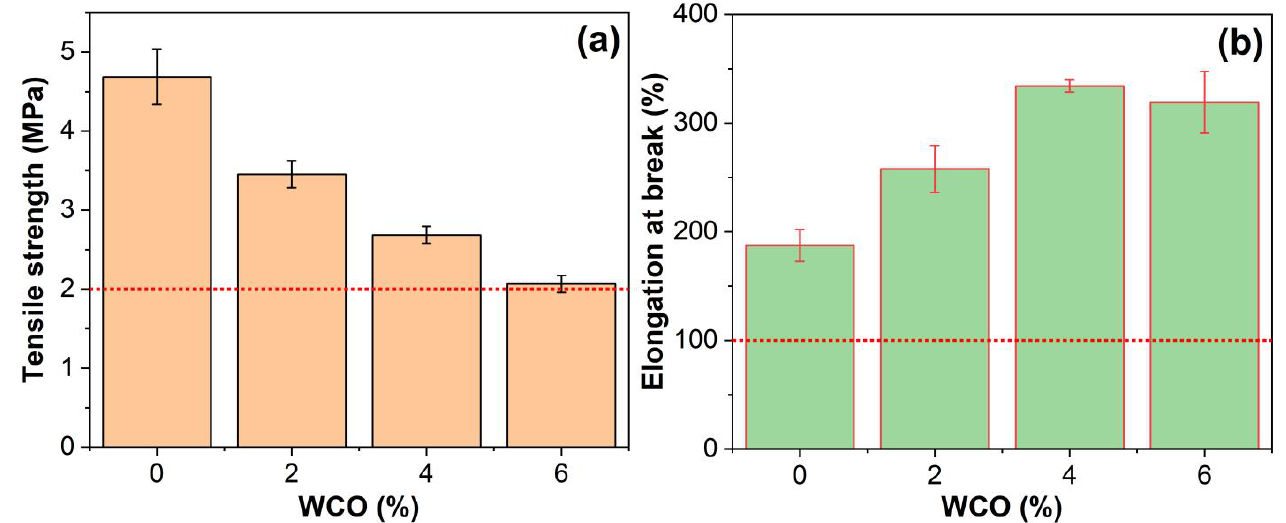
Figure 6. ( a ) Tensile strength and ( b ) elongation at break of the unmodified and WCO-modified EAR binders.